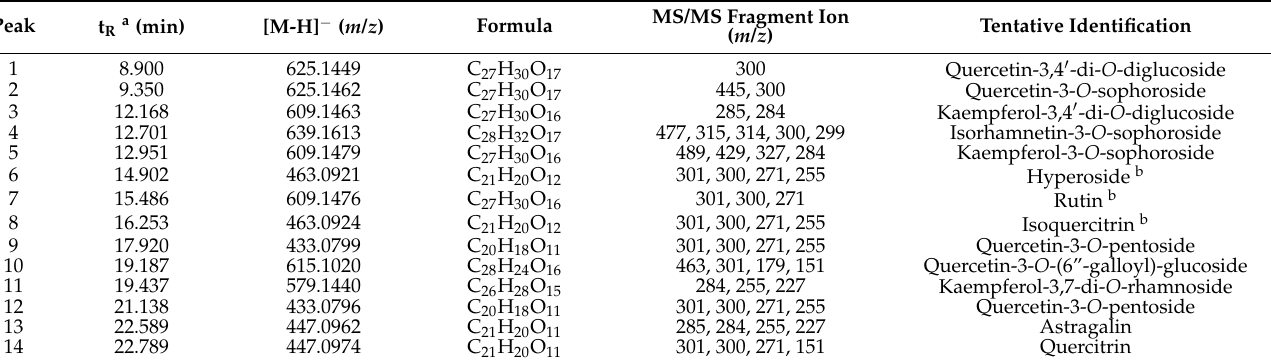
Figure 3. Base-peak chromatogram (in negative ion mode) of the purified extracts from Rosa setate x Rosa rugosa wastes. Table 1. Flavonoids identified in purified extracts from Rosa setate x Rosa rugosa waste using UHPLC-